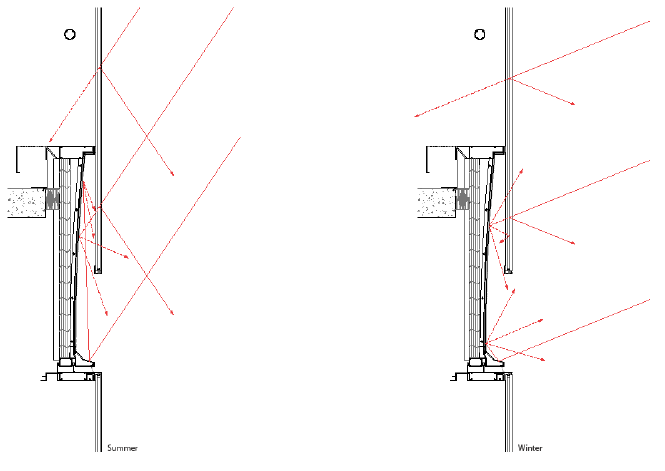
Figure 18: interaction of Linear Lap and summer and winter daylight